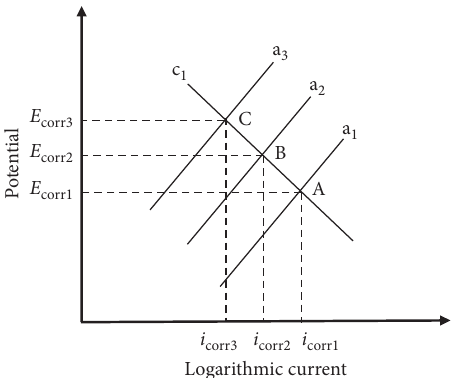
Figure 12: Schematic illustration of ideal polarization curves of C1 (point A, E corr1 and i corr1 ), C2 (point B, E corr2 and i corr2 ), and C3 (point C, E corr3 and i corr3 ) coatings in 0.5 M NaCl solution. The symbol c1 represents the cathodic polarization curve of all the coatings, and the symbols a 1 , a 2 , and a 3 represent the anodic polarization curves of C1, C2, and C3 coatings,